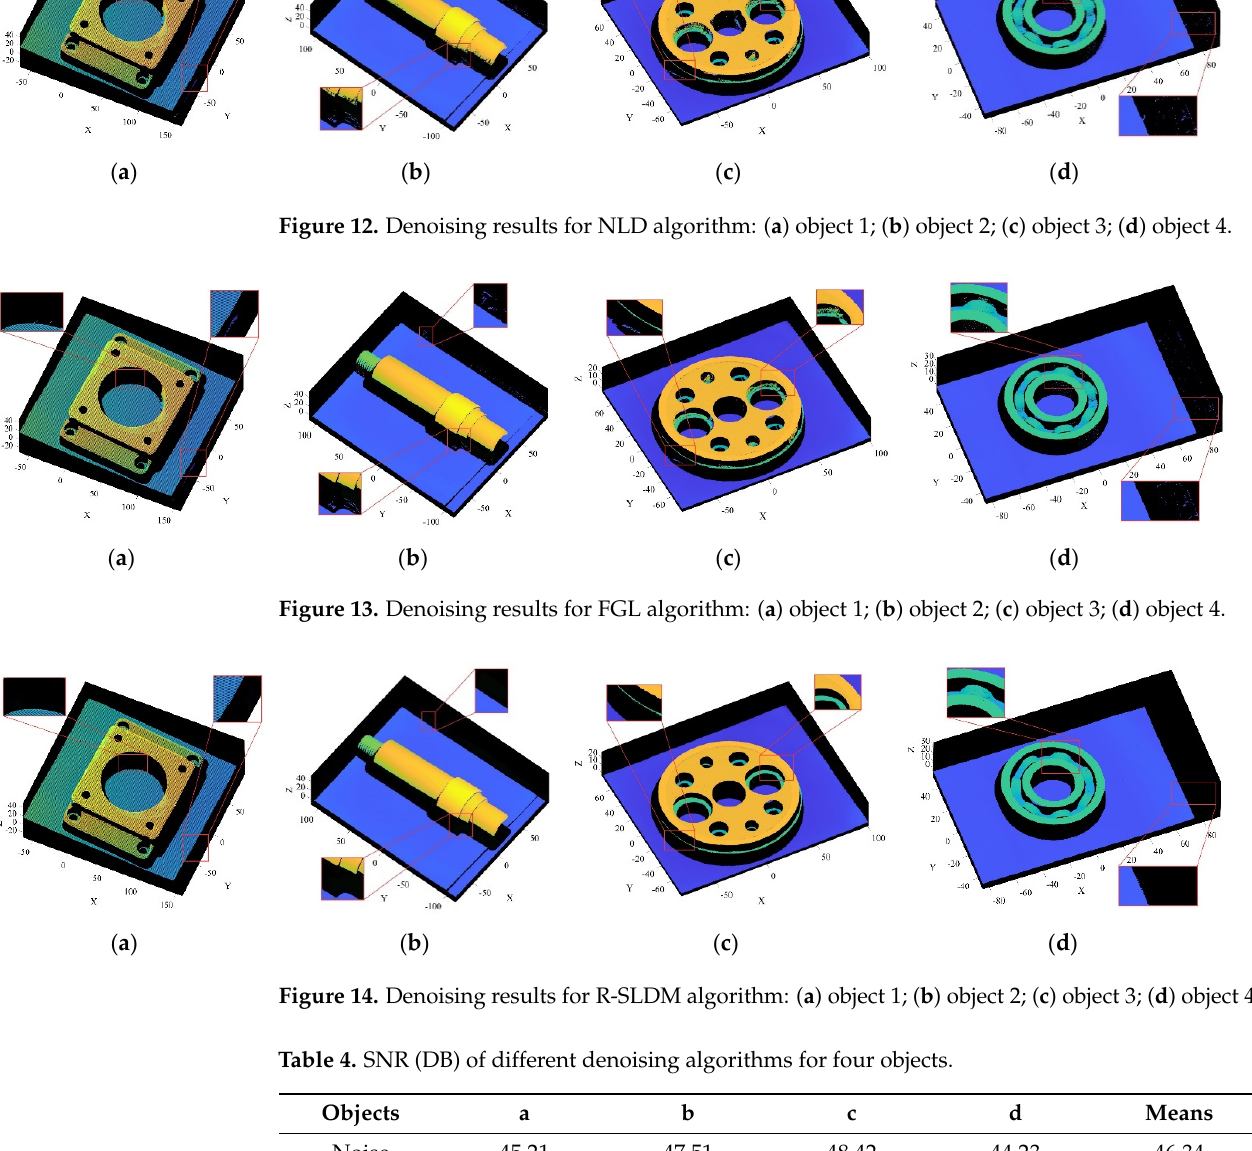
Table 4. SNR (DB) of different denoising algorithms for four objects.